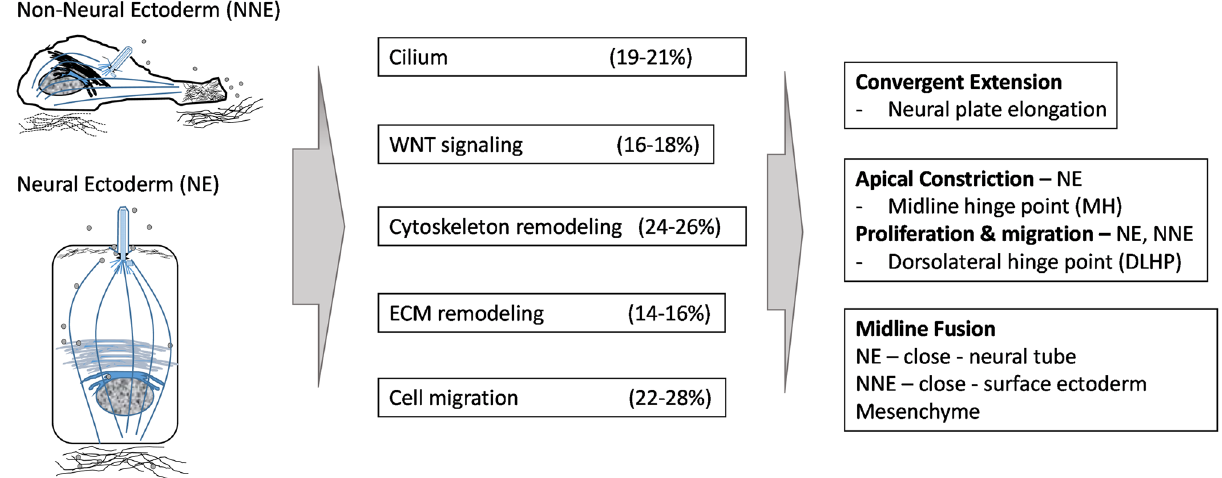
Figure 6. Summary of proportion of study subjects with URDV-containing NTD candidate genes constituting the components of cilium structure and function, WNT-signaling, cytoskeleton remodeling, extracellular matrix (ECM) remodeling and cell migration. URDVs were identified in the DNAs extracted from blood lymphocytes and expected to be present in all body cell types including both neural and non-neural ectodermal cells (NE